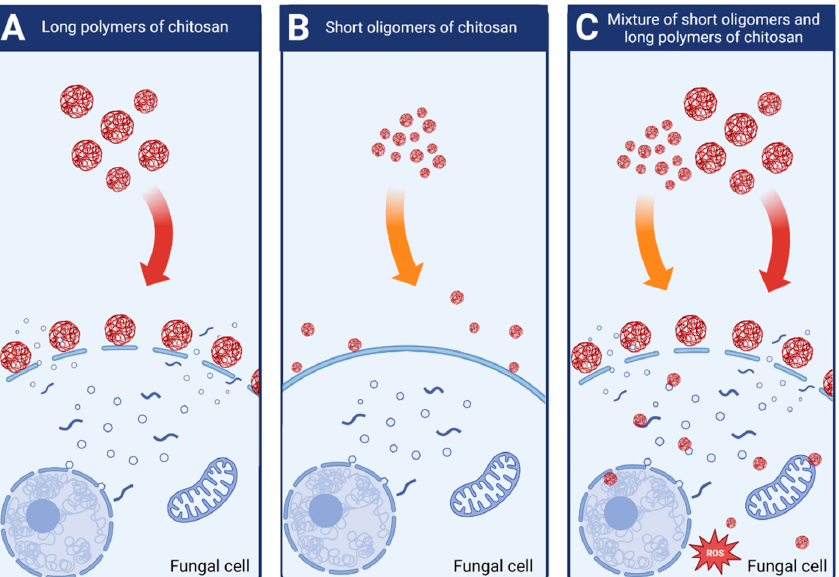
Figure 4. Schematic mechanisms of antifungal activity of different weight fractions of chitosan. ( A ) High molecular weight chitosan destabilizes fungal cell membranes leading to the leakage of intracellular components. ( B ) Low molecular weight chitosan fractions do not destabilize fungal membranes and show very weak antifungal effect. ( C ) Chitosan mixture of high and low molecular weight fractions shows strong antifungal activity. High molecular weight fractions destabilize the membranes allowing the low molecular fractions to penetrate fungal cell and to disturb cell processes.